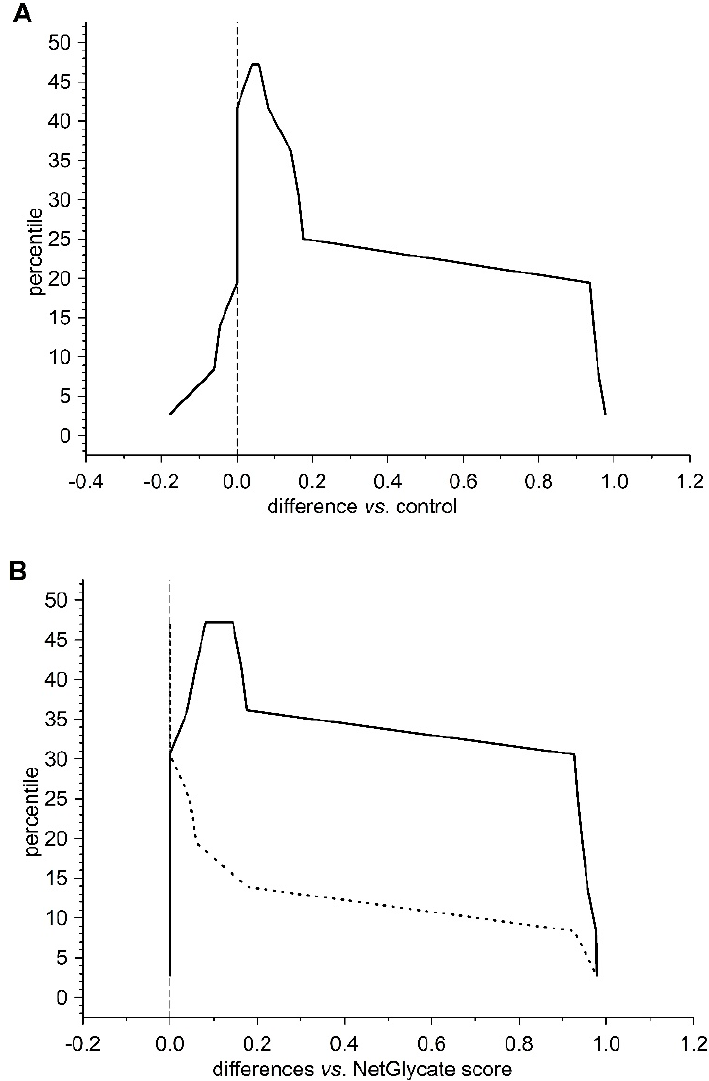
Figure 6. Mountain plots comparing the NetGlycate scores of glycation sites in control subjects and T2DM patients with theoretical estimates for glycation positions of high or low glycation potential in gamma chain of fibrinogen. The plot was created by evaluating the percentiles for ascending di ff erences between the normalized scores: ( A ) di ff erences of the NetGlycate-estimated scores (normalized to the scale from 0 to 1) between diabetic patients and control subjects ( norm score diabetic − norm score control ), ( B ) di ff erences of the NetGlycate-estimated scores (normalized to the scale from 0 to 1) between theoretical estimates for high or low glycation potential sites and the actual glycation sites revealed in diabetic patients (solid line) and control subjects (dashed line) ( norm score theoretical − norm score control ; norm score theoretical − norm score diabetic ).